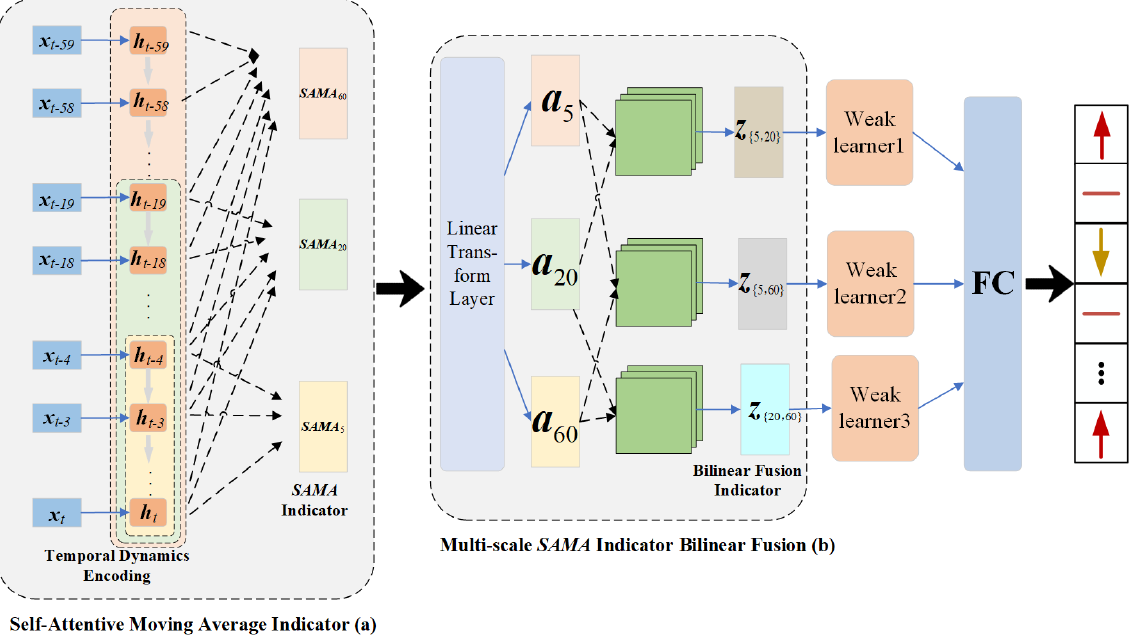
Figure 1. The overall framework. In part ( a ), the input signal of a time series is encoded through a recurrent neural network, and then a self-attention mechanism is introduced to adaptively determine the weight of the data at each time step to calculate the SAMA indicators. Multiple self-attention heads are used to model multiple moving average indicators of different scales. In part ( b ), the bilinear fusion method is used to fuse information between the dimensions of any two